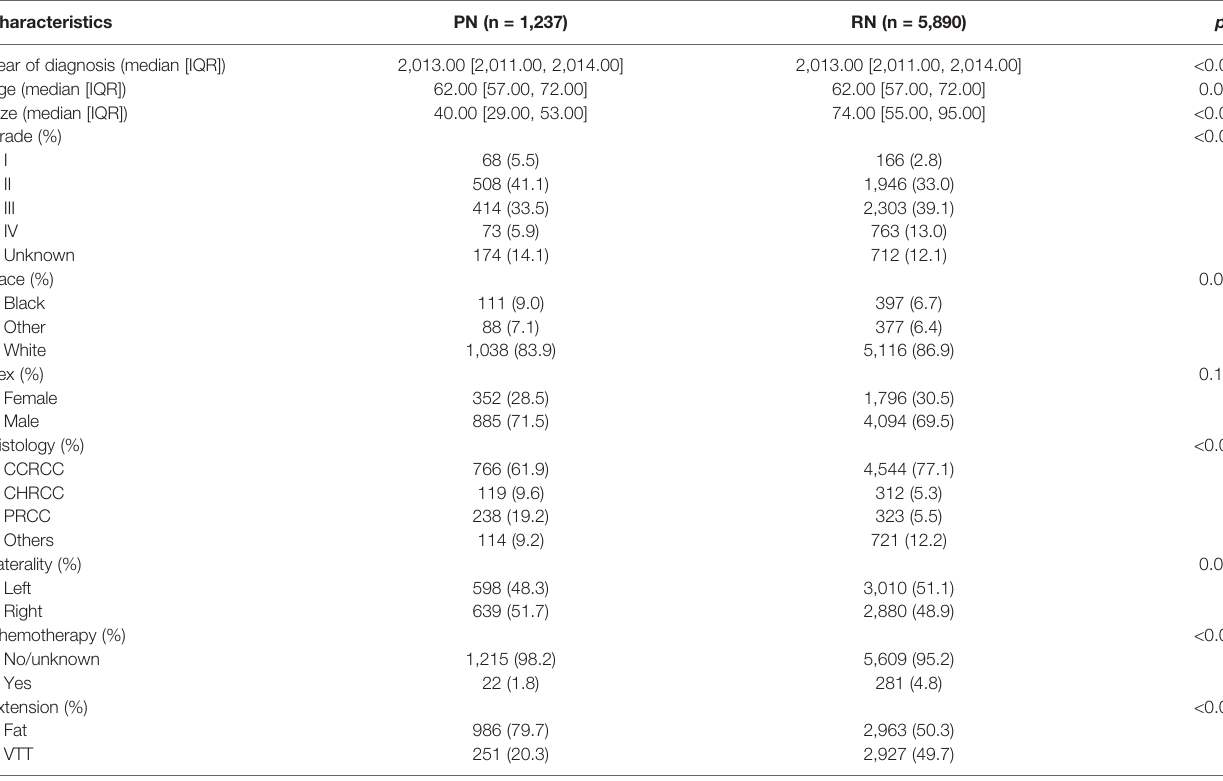
TABLE 1 | Characteristics of PN and RN groups in SEER